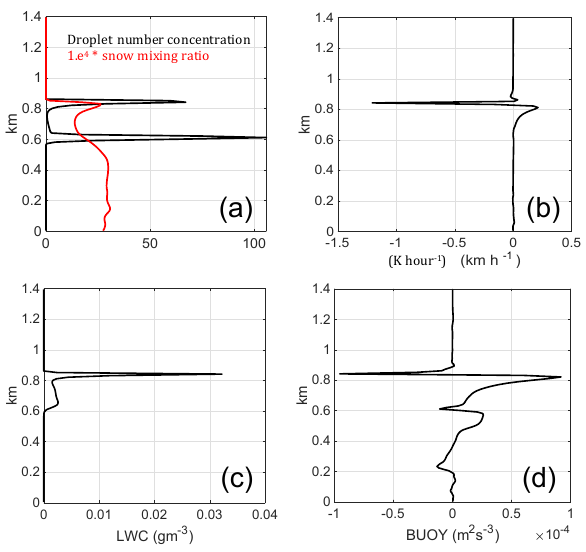
Figure 9. Impact of prognostic CCN (LinIce2.0–FixCCN2.0) over hour 10. (a) Droplet number concentration (black) and snow mix- ing ratio (red), in units of cm − 3 and 1 × 10 4 gkg − 1 , respectively. (b) Longwave radiative heating rate, in units of Kh − 1 . (c) Liquid water content, in units of gm − 3 . (d) Buoyancy, in units of m 2 s − 3